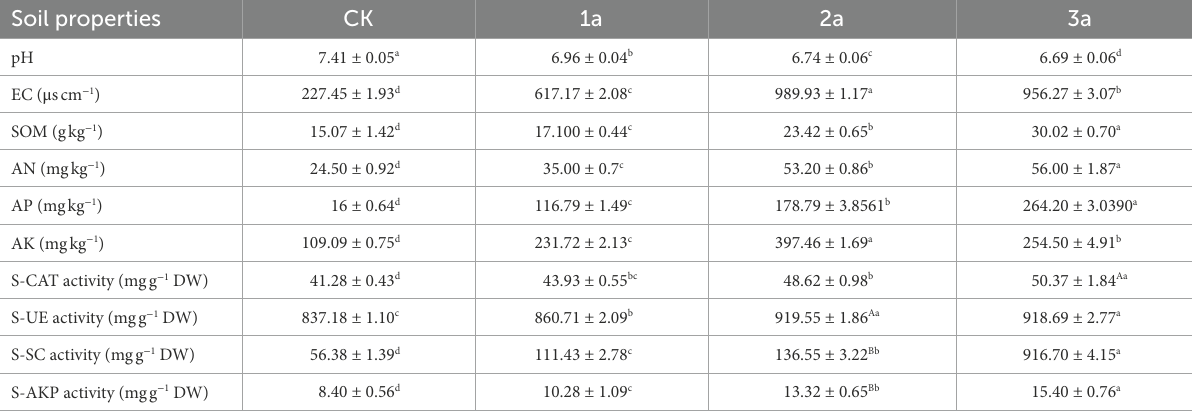
TABLE 1 Rhizosphere soil properties in different